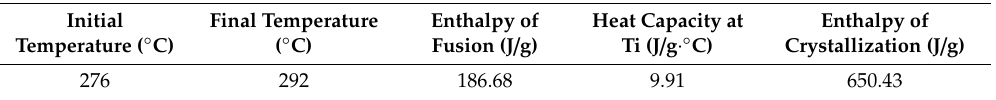
Table 1. Di ff erential scanning calorimetry analysis results for chitosan-ascorbic acid@NiFe 2 O 4 within the temperature range of 50–350 ◦